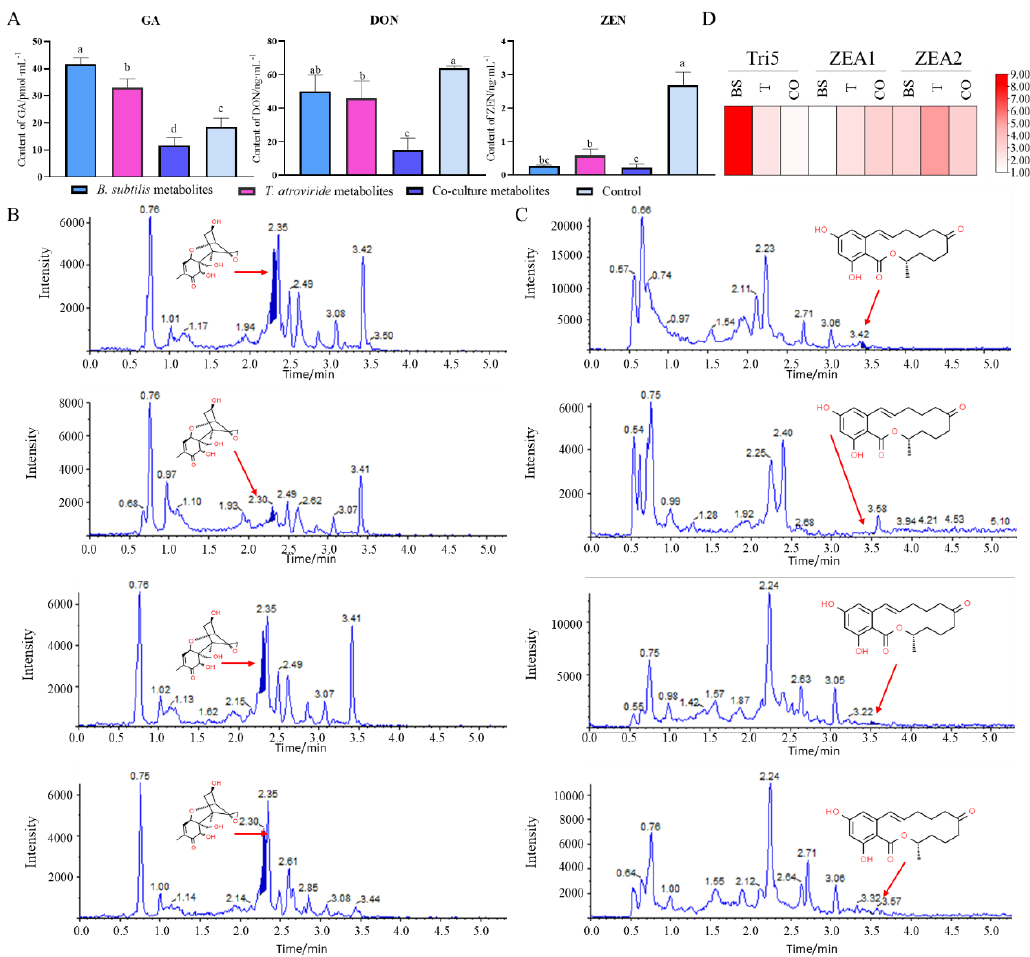
Figure 4. Effects of the co-culture and the axenic culture of T. atroviride and B. subtilis on the production